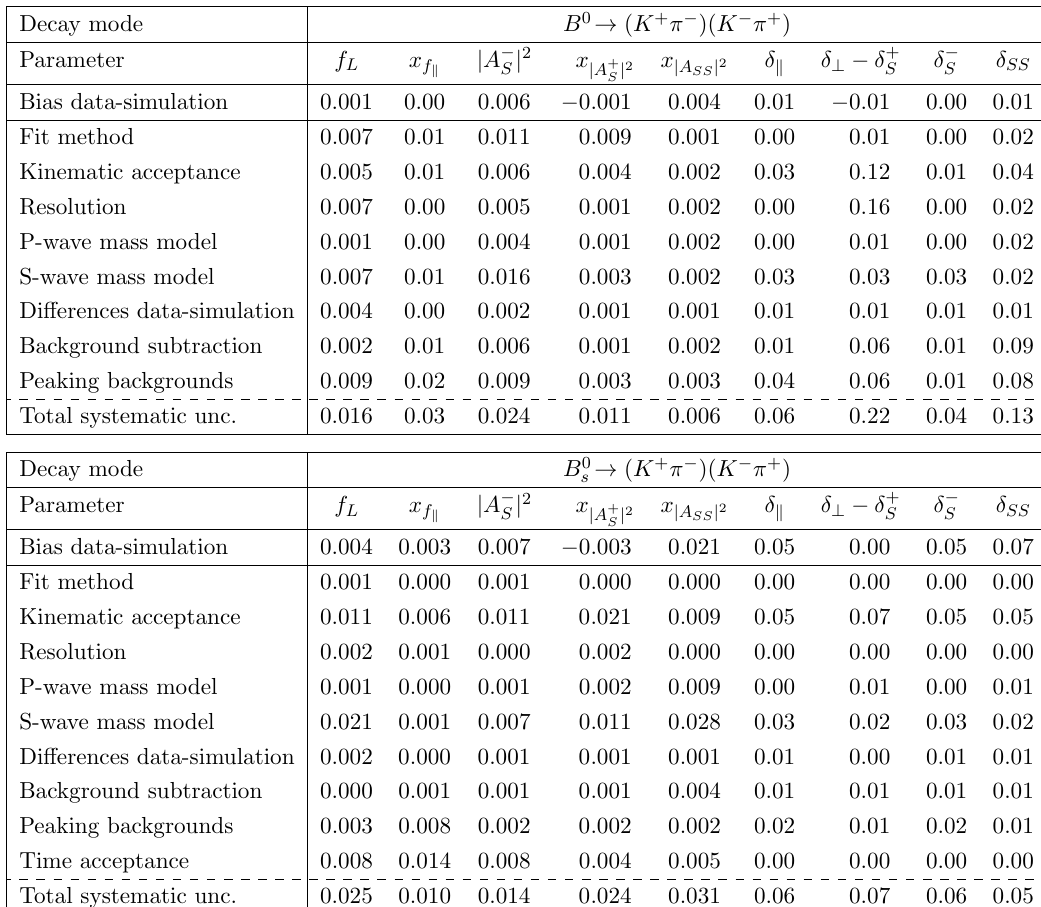
Systematic uncertainties for the parameters of the amplitude-analysis (cid:12)t of the B 0 ( K + (cid:25) (cid:0) )( K (cid:0) (cid:25) + ) decay. The bias related to di(cid:11)erences between data and simulation is ( s ) ! included in the results shown in table